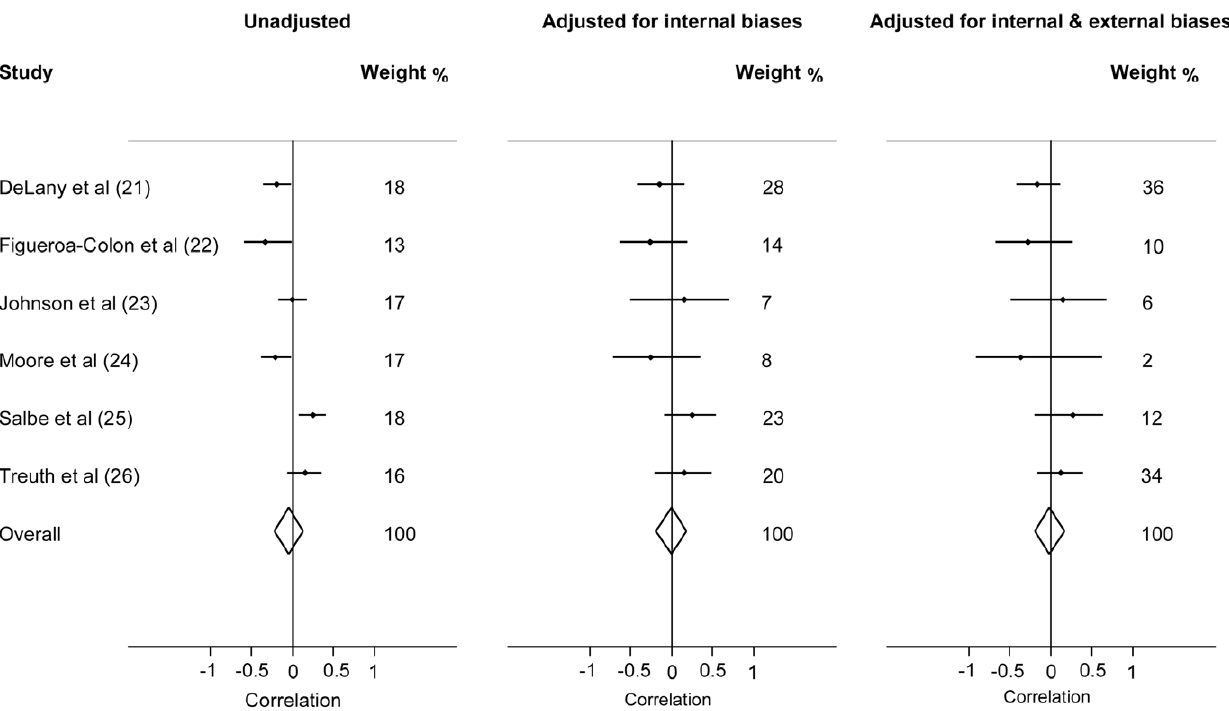
Figure 3. Random-effects meta-analyses unadjusted, adjusted for internal biases and adjusted for internal and external biases. The six studies evaluate the prospective associations between measured physical activity and subsequent change in adiposity in children. The correlation in each source study and the combined correlation are presented, with 95% confidence intervals.